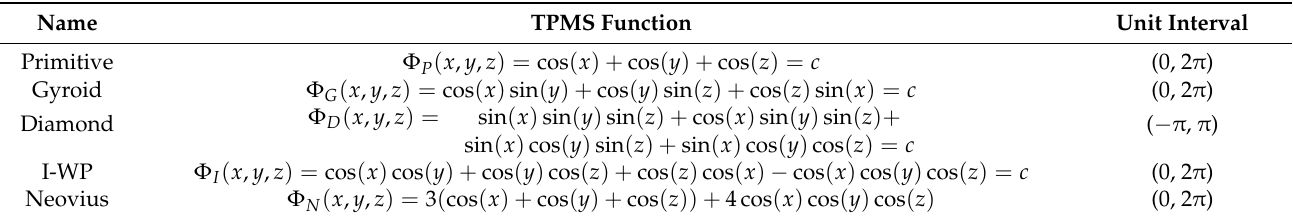
Table 1. Typical TPMS